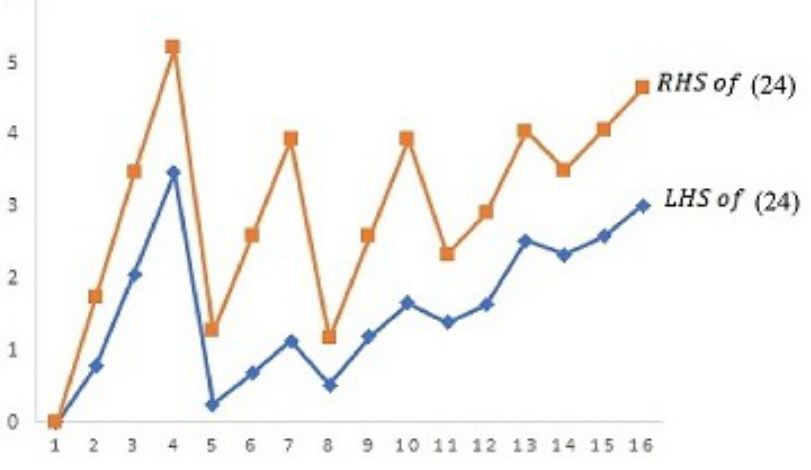
Figure 2. Illustration of contractive inequality (24) using Example 3. Hence, all the assumptions of Theorem 2 are satisfied. We therefore see that u = 0 is a fixed point of Υ